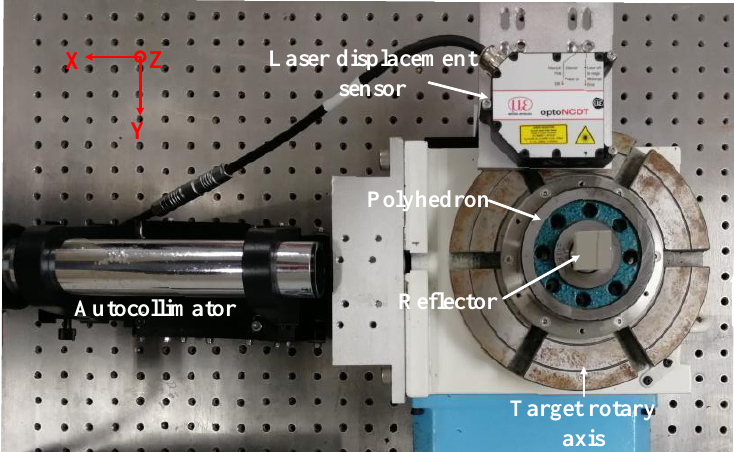
Figure 4. Experimental device for measuring angle positioning error, the tilt motion error around the Y axis, and the radial motion error along the Y direction of the target rotary axis. Table 2. The specific parameters of the autocollimator and laser displacement